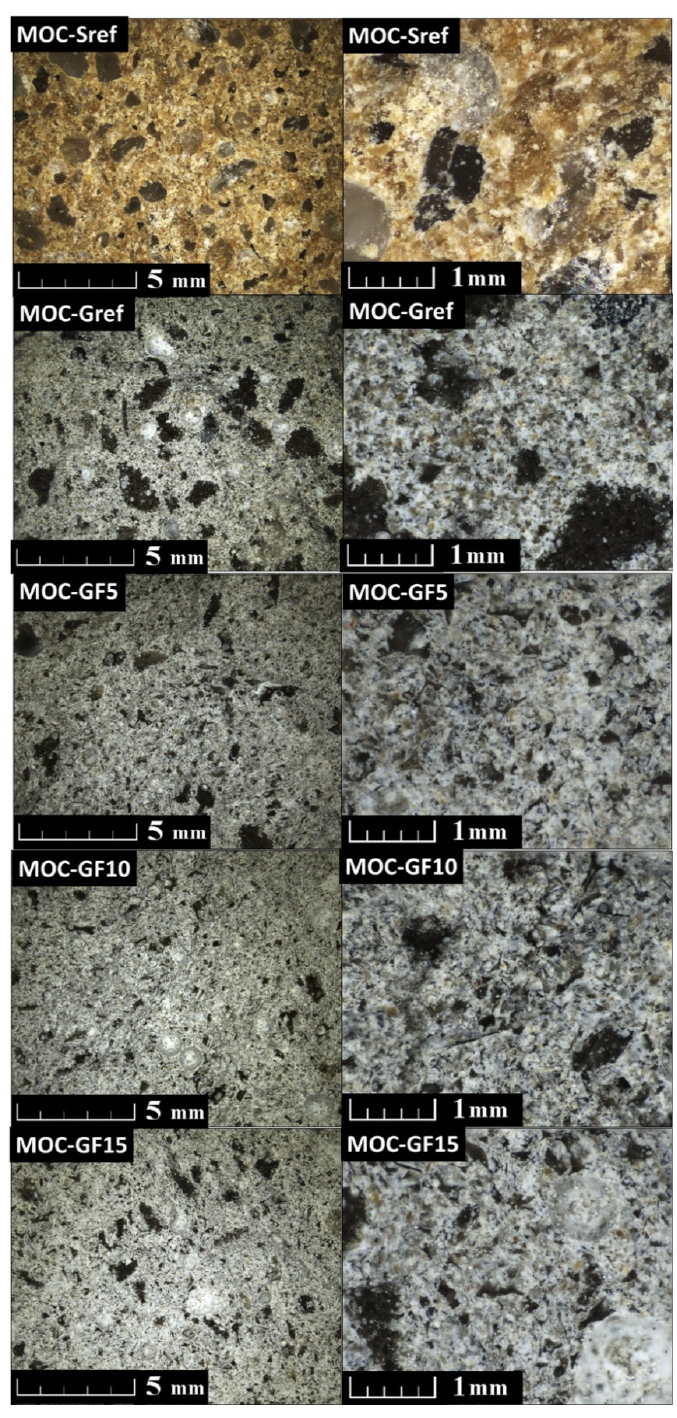
Figure 4. Structure of prepared composites analyzed by LM.